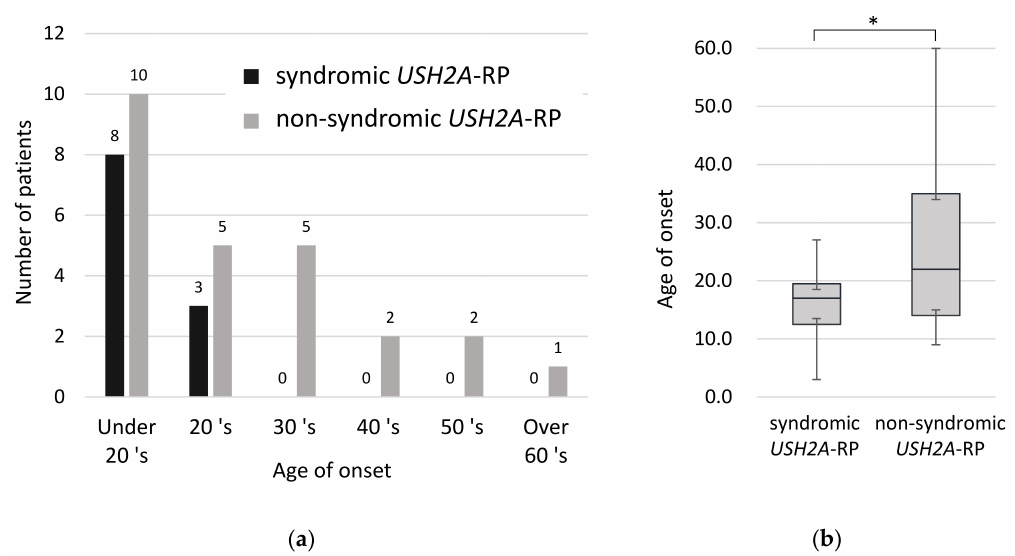
Figure 4. Onset age of RP in 11 syndromic and 25 non-syndromic USH2A -RP patients. ( a ) Distribution of onset age in syndromic and non-syndromic USH2A -RP patients. The vertical line shows the number of patients and the horizontal one shows the onset age of RP. Numeric numbers above each column indicate patients’ numbers. ( b ) Box plot of onset age in syndromic and non-syndromic USH2A -RP patients. The bottom and top of each box represent the lower and upper quartiles, respectively, and the line inside each box represents the median. The bottom and top bars represent the minimum and maximum value, respectively. p < 0.05 (*).